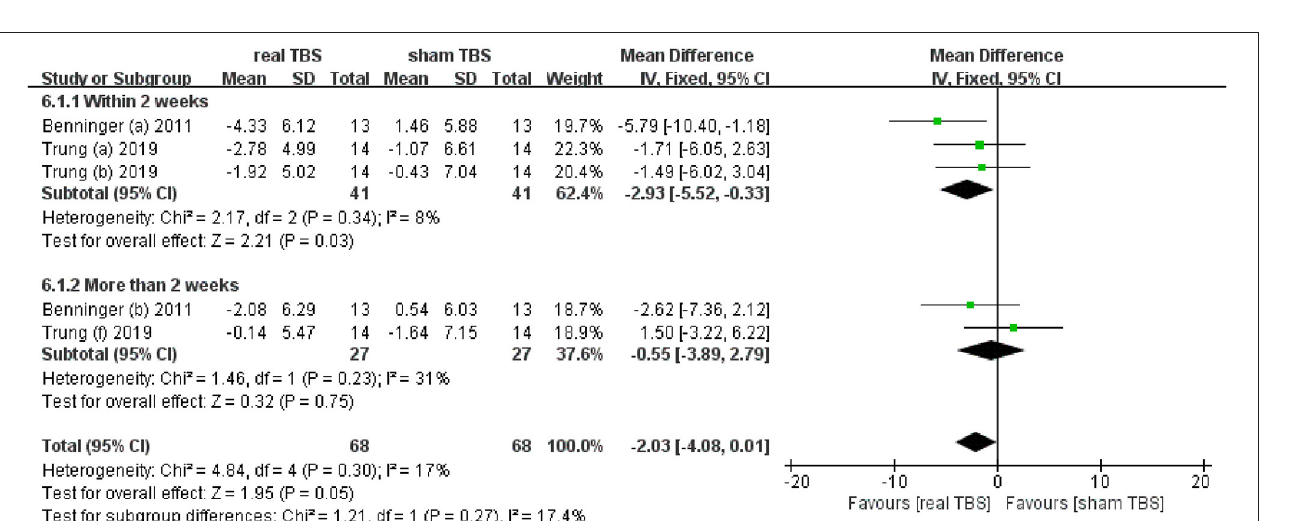
movement disorder both in the “on” medicine